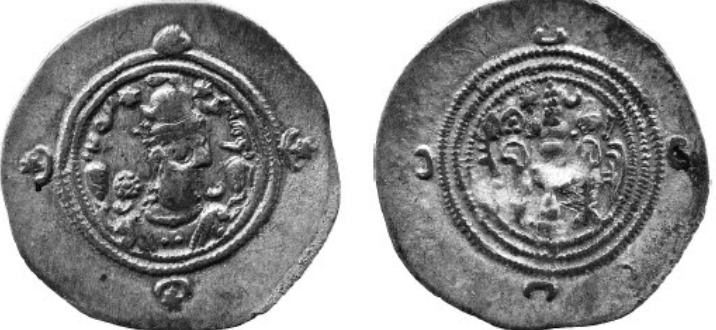
Figure 6. Khosrow II’s coin ‐ type I, impression on silver, 590, Tehran, National Museum of Iran. Khosrow’s regaining of power was marked by a change in his crown depicted on the coins belonging to the second regnal year (Figure 7). Two wings were added to the crown while a crescent and a star were added between them. This imagery continued to symbolize Khosrow’s crown until the end of his rule. The legend on the left side of the crown gave place to the farreh afzun (i.e., may regal splendor increase, or he has increased the regal splendor [56] (p. 461)). Furthermore, stars were added to the crescent of the outer margin on the reverse. Touraj Daryaee, the renowned Iranologist and historian of the Sasanian dynasty, suggests that the wings on Khosrow’s crown, which appeared from the second year of his sovereignty onwards, symbolize Wahram (i.e., a deity related to victory in ancient Persian beliefs), “whose avatars is the falcon”. Since Wahram’s farr was more than anyone else’s, by using his symbol, Khosrow declares his victory over the rebellious